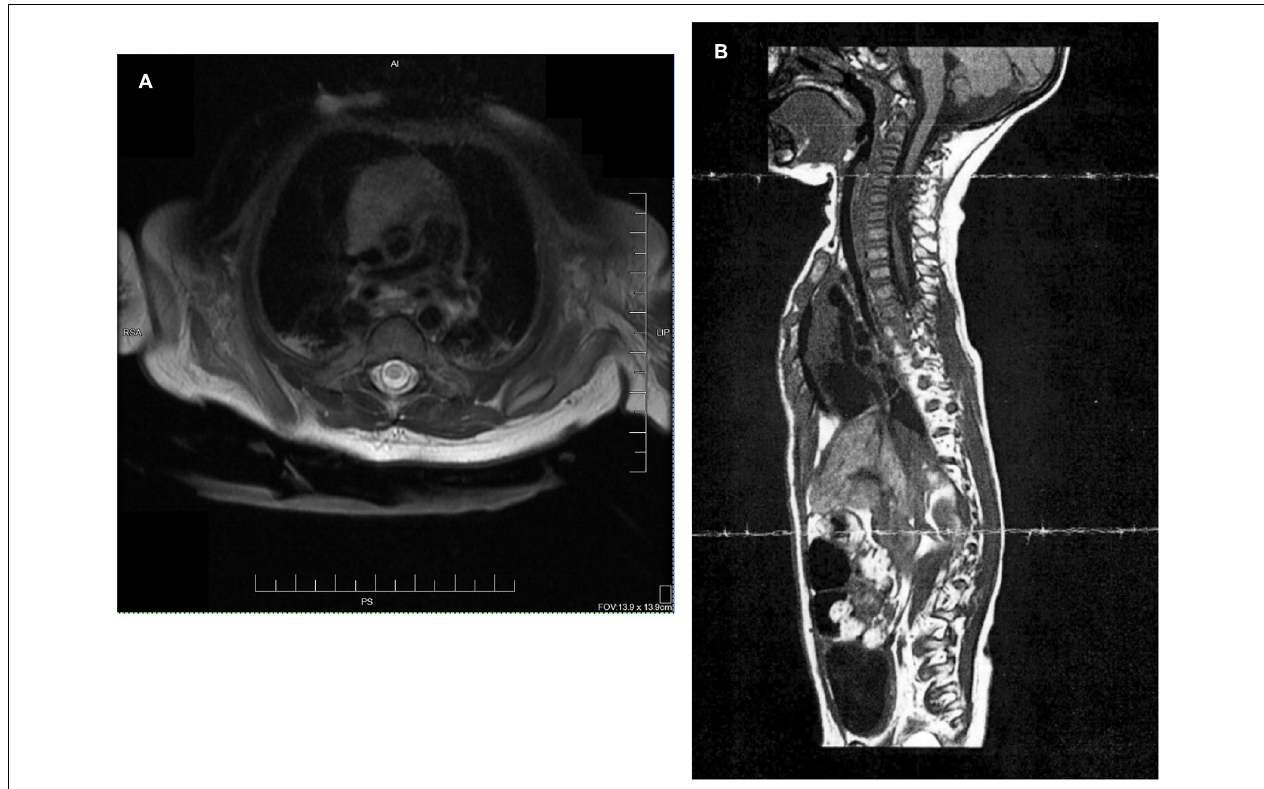
FIGURE 2 | (A) Transaxial T2 sequence: MRI of cervical spine revealed cystic myelomalacia involving mid and lower upper thoracic spinal cord between inferior C4 and T1 levels at age 1 month. (B) MRI sagittal image at 11 months of age again shows cystic myelomalacia from